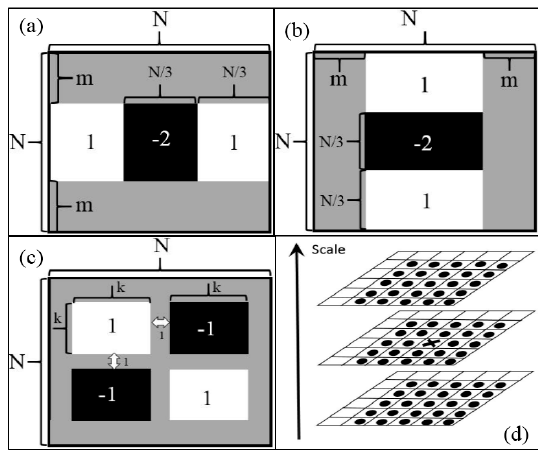
Figure 1. ( a ) Filter box in X direction; ( b ) filter box in Y direction; ( c ) filter box in XY direction; ( d ) 3D non-maximal suppression.